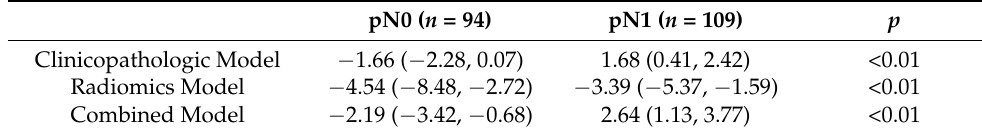
Figure 3. Violin plot of predict models for pN0 and pN1 patients in the training set ( a ). The black dot represents the median. The black line is the range from the lower quartile to the upper quartile. The waterfall plot of the Combined Model was used to visualize the distribution of the pre-scores of individual pN0 and pN1 patients ( b ). The ** represents. p value < 0.01, *** represents. p value < 0.001. Table 2. Pre-scores of predict models for early-stage breast cancer patients in training